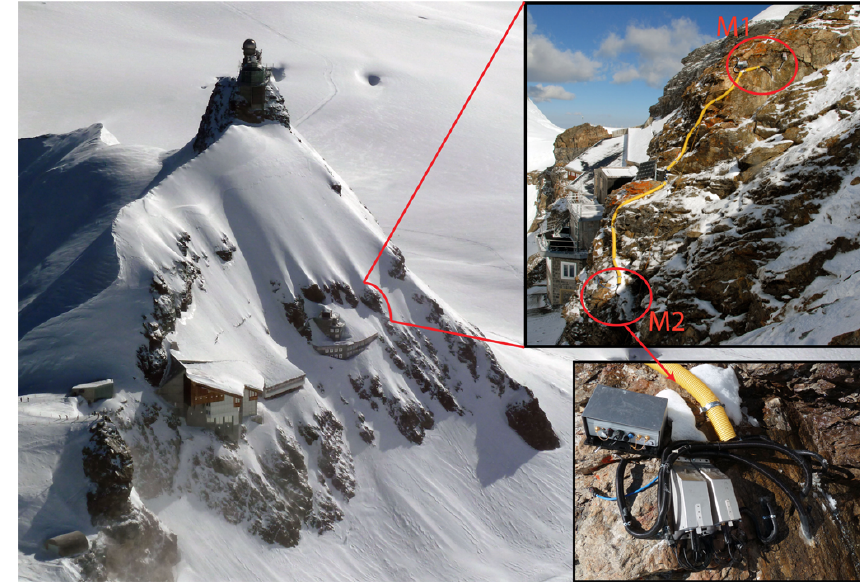
Fig. 8. Field deployment at Jungfraujoch, close-up of the measurement site, and detail of measurement system M2.